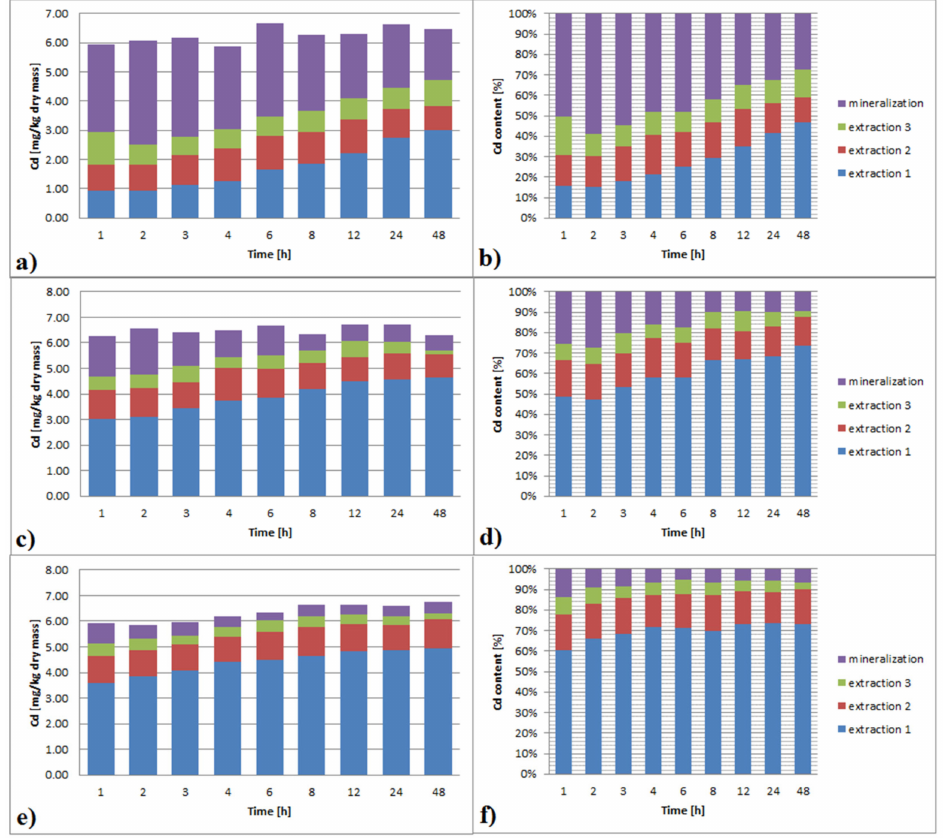
Figure 3. ( a – f ) . Cd extraction from bottom sediments with different EDTA concentrations ( a , b ): 0.01 M; ( c , d ): 0.05 M; ( e , f ): 0.1 M and extraction